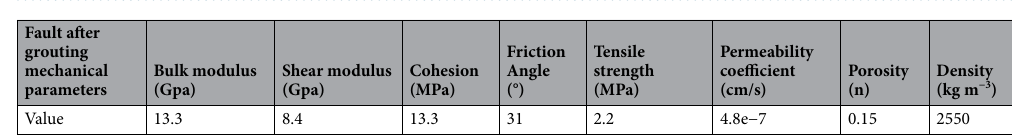
Table 2. Mechanical parameters of fault zone after